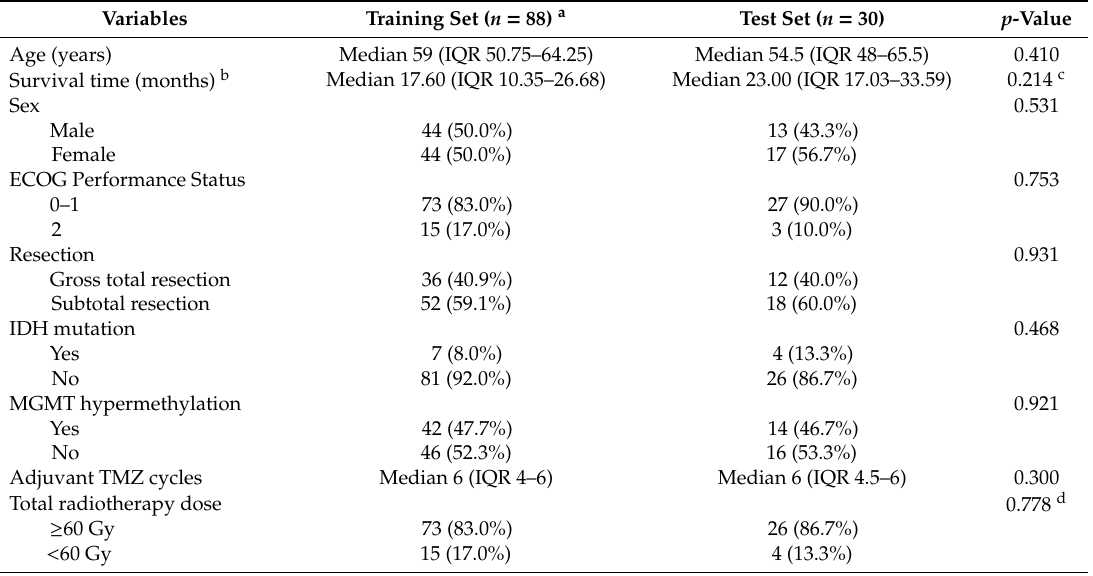
Table 1. Baseline patient characteristics ( n = 118).